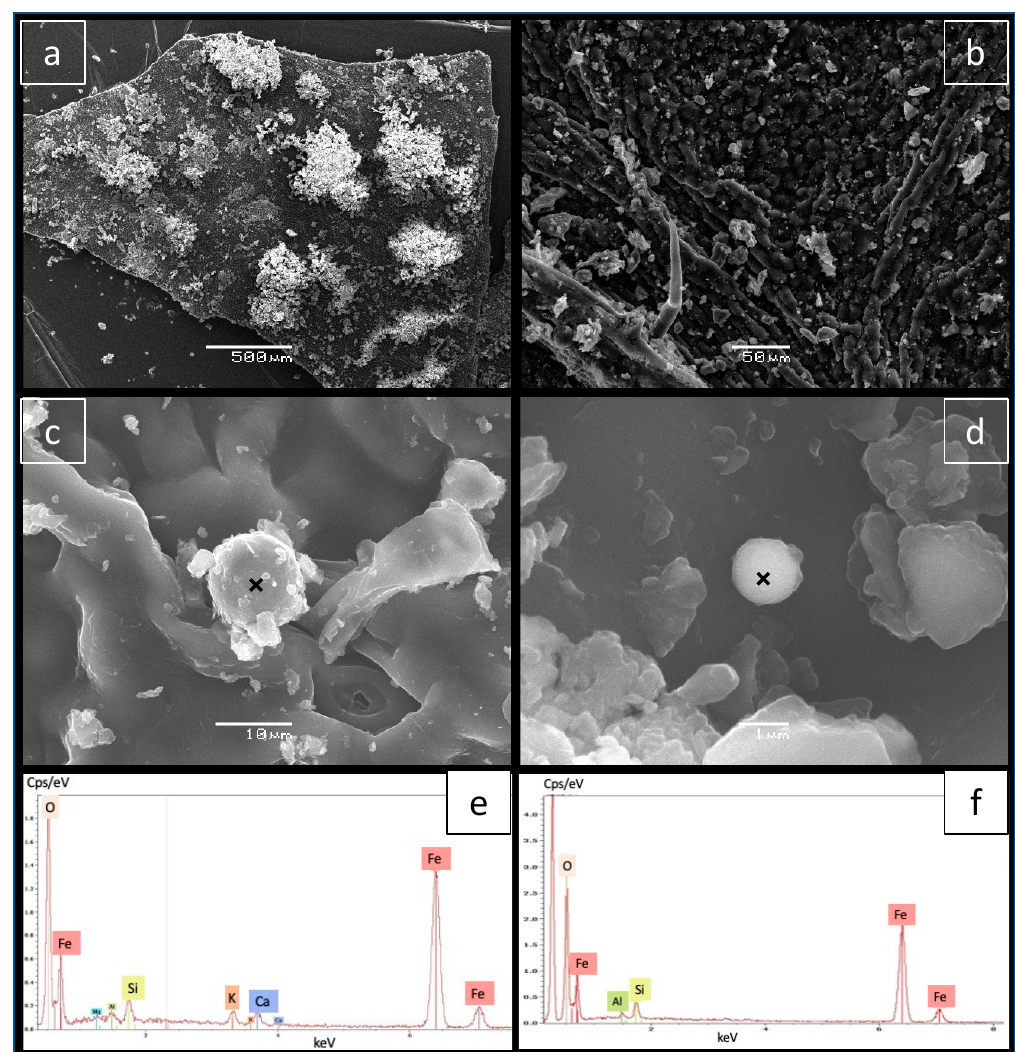
Figure 8. SEM observations ( a – d ) and EDS spectra ( e,f ) acquired on the location marked by the cross on c and d, respectively. ( a ) Leaf from site D13 taken during campaign D. All others: leaf from site D48 taken during campaign